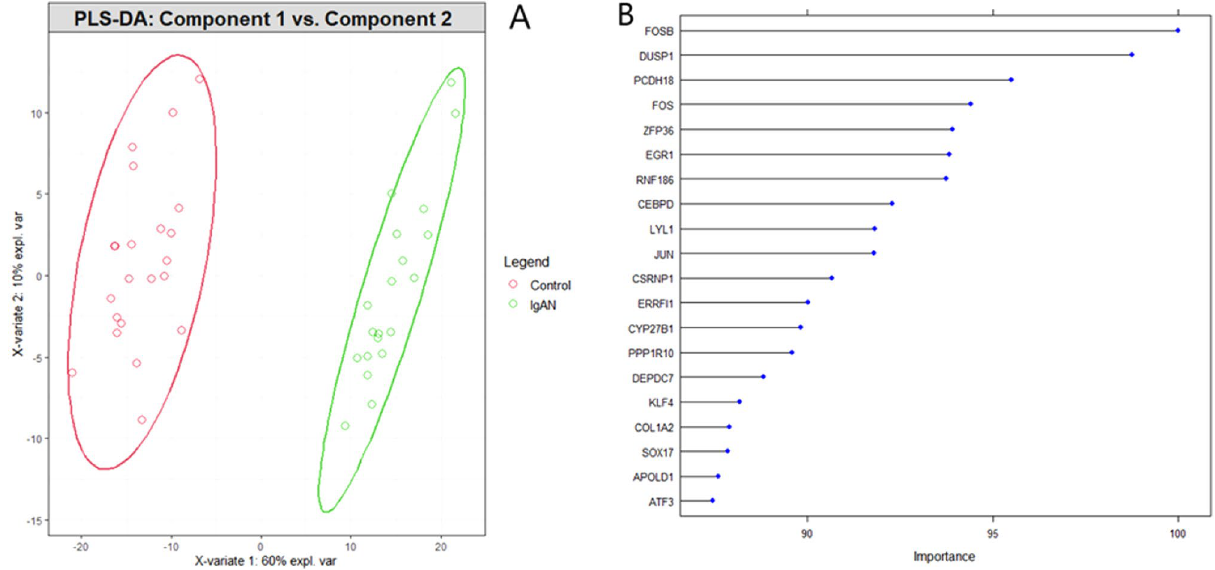
Figure 6. PLS-DA for DEGs: ( A ) Component 1 vs. Component 2. The red points indicate IgAN patients and the green points indicate healthy control; ( B ) Importance of top 20 discriminative genes for IgAN.